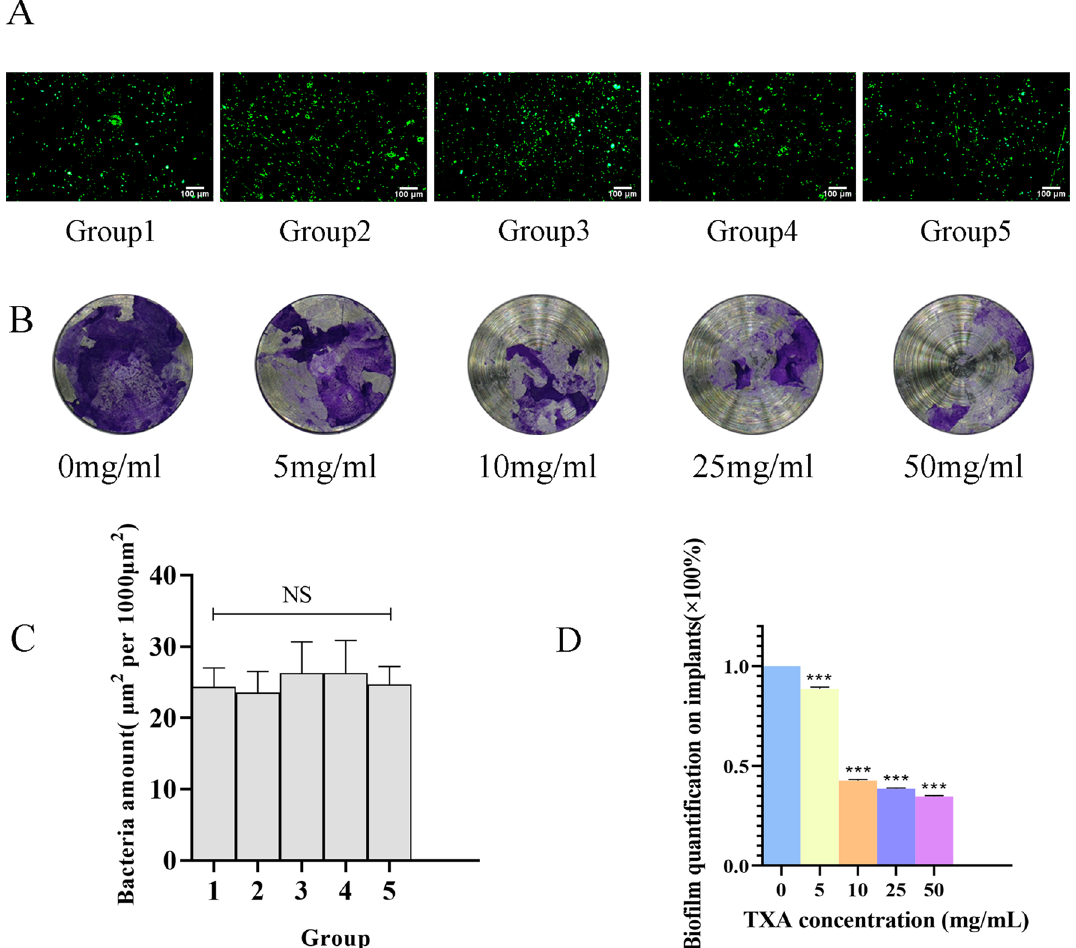
Figure 4. ( A ) Fluorescence observation (scale bar: 100 μm) and ( C ) quantification results of bacteria attached on disks 1, 2, 3, 4, and 5 after 24 h of culture. ( B ) Crystal violet staining results and ( D ) quantification of biofilms attached to implants after treatment with TXA at different concentrations for 3 days. The results were quantified as the mean of three independent experiments and analysed by one-way ANOVA (* p < 0.05 indicates statistical